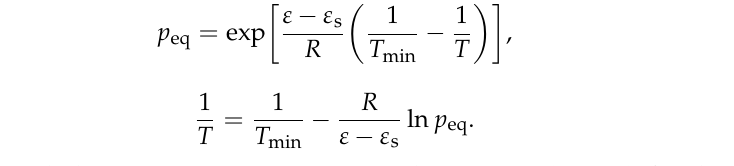
only in austenitisation temperature region between 730 and 820 °C.